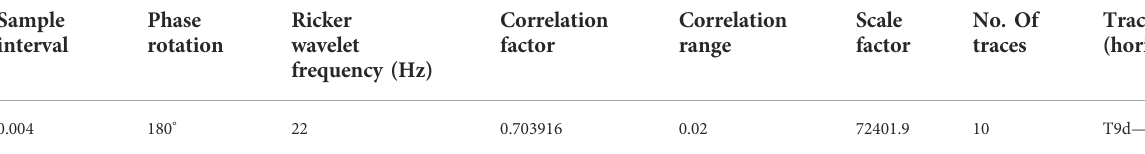
TABLE 1 Selected parameters for optimum wavelet estimation within the study area.